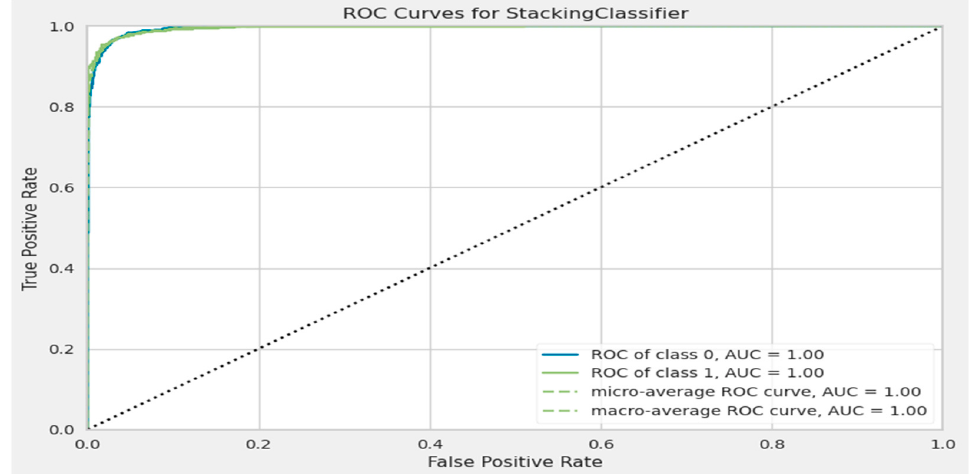
Figure 13. The RXLM model’s ROC curve after the hyper-parameter tuning.